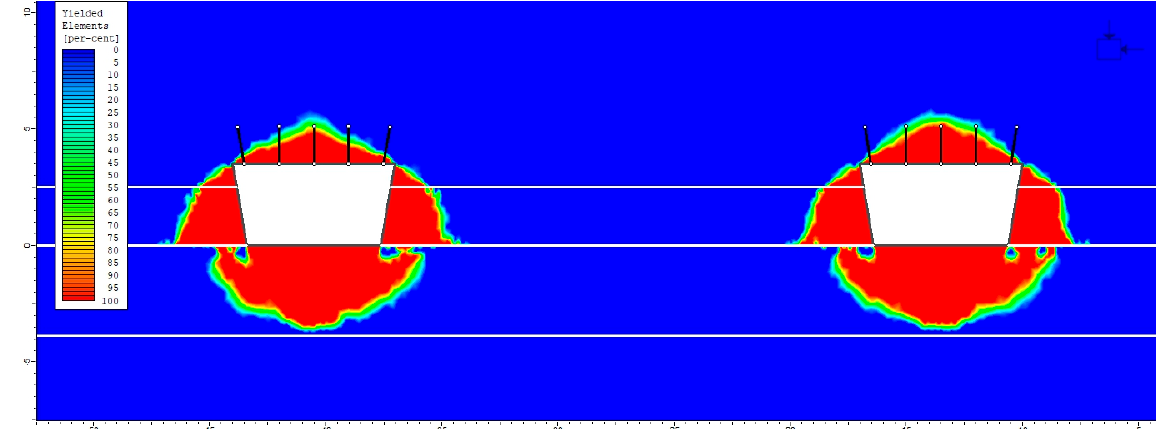
Energies 2021 , 14 , x FOR PEER REVIEW 11 of 13 Figure 6. Yielded element area around heading – 1 and heading – 2, load variant – 2. Figure 6. Yielded element area around heading – 1 and heading – 2, load variant – 2. Figure 6. Yielded element area around heading 1 and heading 2, load variant 2.